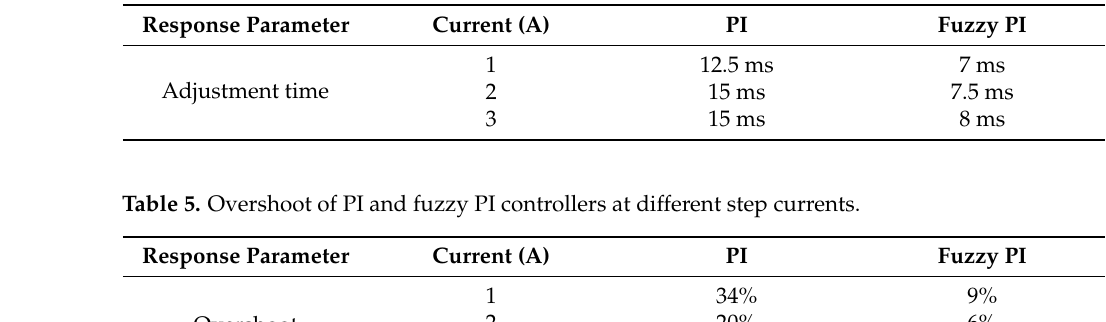
Figure 14. Response of current driver at 1 A, 2 A, 3 A step current: ( a ) PI controller; ( b ) fuzzy PI controller. Table 4. Adjustment time of PI and fuzzy PI controllers at different step currents.